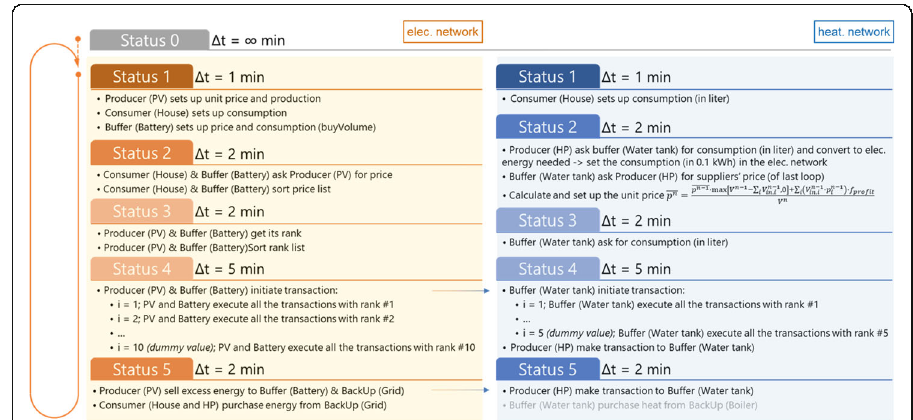
Fig. 2 Timeline of the 5-step trading mechanism. (Left: for electricity network; Right: for heating